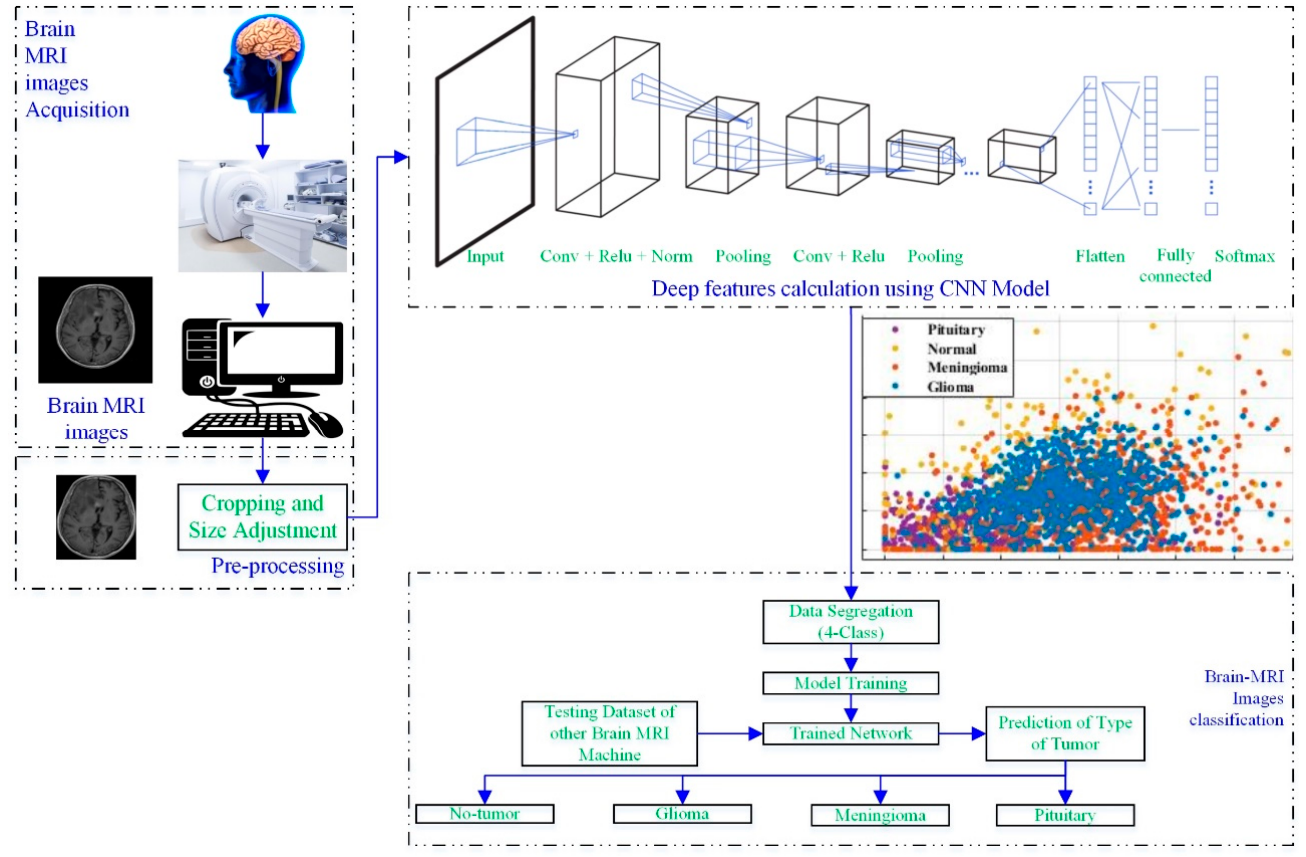
Figure 1. Working framework of the proposed approach.